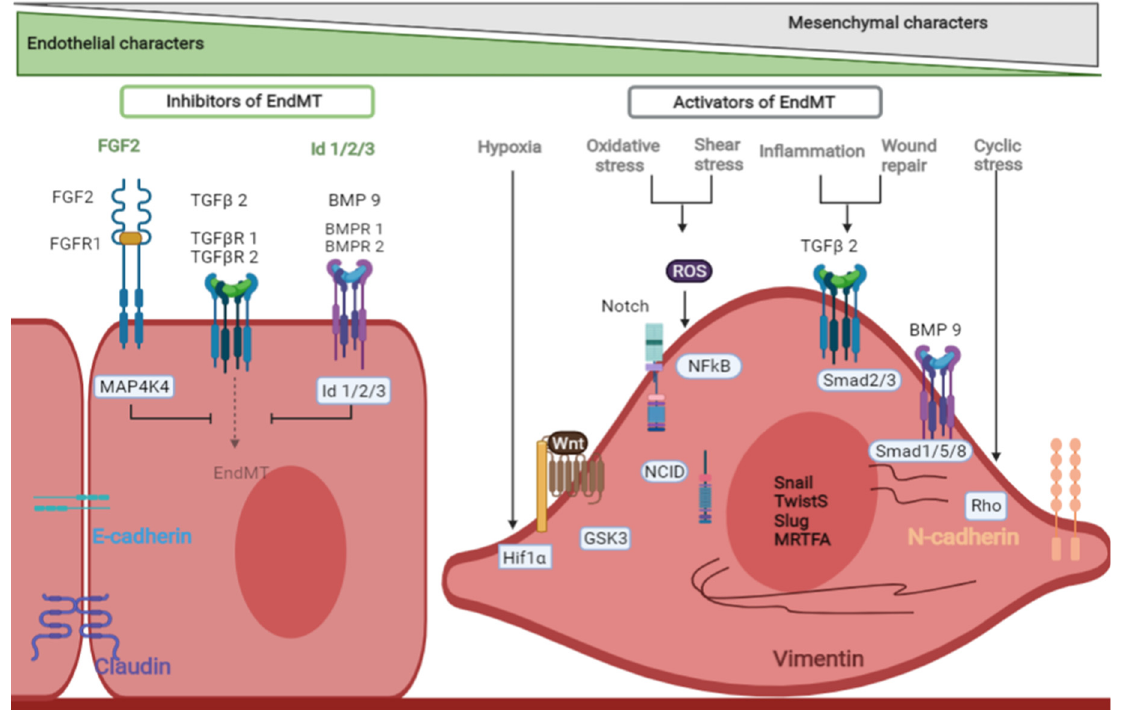
Figure 2. Signalling pathways that initiate and drive endothelial to mesenchymal transition (EndMT). Image produced in BioRender.